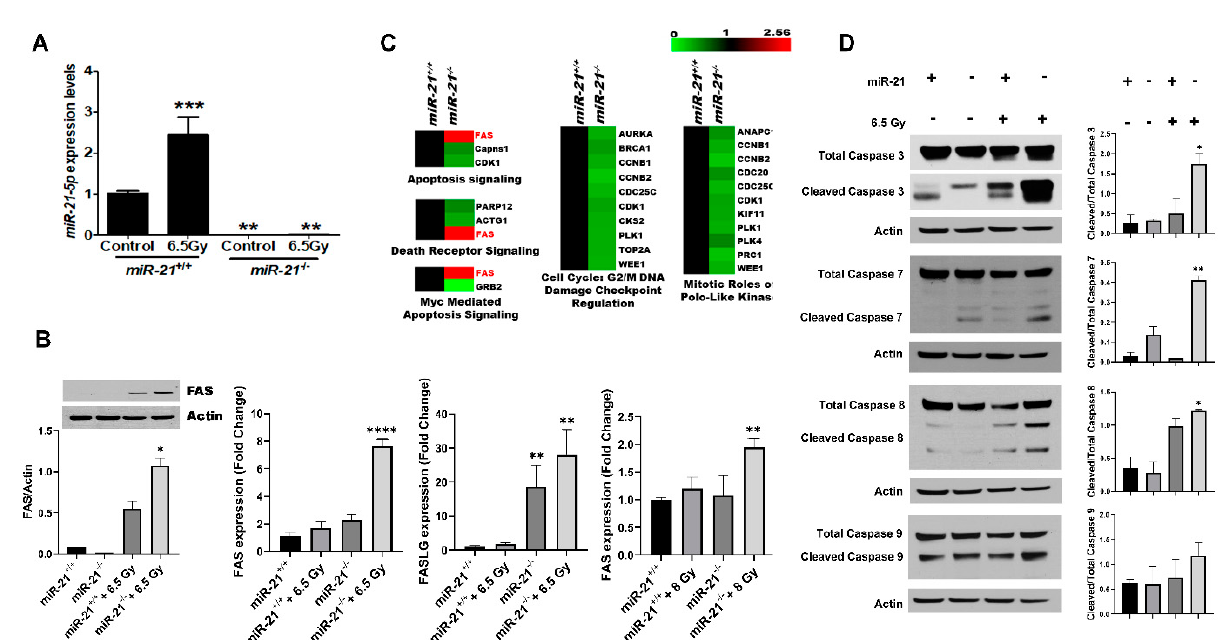
Figure 4. Apoptosis and death receptor signaling pathways contribute to the radiation-sensitive phenotype of the miR-21 − / − mice. ( A ) To investigate the underlying mechanism of radiation sensitivity conferred by loss of miR-21, tumors generated from miR-21 − / − ;MMTV-PyMT and miR-21 +/+ ;MMTV-PyMT mice were exposed to 6.5 Gy irradiation, and collected after 24 h. Irradiation caused a 2.5-fold induction of miR-21 in the tumors derived from miR-21 +/+ ;MMTV-PyMT mice, whereas no increase was noted in the miR-21 − / − tumors determined using one-way ANOVA (***- p < 0.001, **- p < 0.01, n = 3/group). ( B ) As FAS and FASL are known targets of miR-21, the inverse correlation in the expression of miR-21 and FAS was confirmed transcriptionally and at the protein level for Fas in tumors derived from miR-21 − / − ;MMTV-PyMT and miR-21 +/+ ;MMTV-PyMT mice exposed or not to 6.5 Gy. MDA-MB-468 cells were transfected with 60 nM miR-21 inhibitor or scramble with or without 8 Gy. miR-21 inhibition combined with 8 Gy radiation increased FAS expression by 95% ( p < 0.01) compared to control, and 63% ( p < 0.05) compared control tumors treated with 8 Gy. miR-21 inhibition also caused significant increases in the expression of FASLG ( p < 0.01) in tumors, and FAS ( p < 0.01) in MDA-MB-468 cells treated with 8 Gy and miR-21 inhibitor, determined using one-way ANOVA (****- p < 0.000, **- p < 0.01, *- p < 0.05, n = 3/group). ( C ) Ingenuity pathway analysis revealed the activation of apoptosis and death receptor signaling pathways as top canonical pathways. ( D ) Twenty-four hours after radiation, the activation of the caspase 3, 7, 8, and 9 signaling pathways was evaluated in miR-21 − / − and miR-21 +/+ tumors by western blot and quantified. Significant upregulation of cleaved caspases was noted in the miR-21 − / − tumors ( n = 3/group). In detail, caspase 3 was increased by 90%, 7 by 80%, 8 by 70% and 9 by 50% (**- p < 0.01 , *- p < 0.05 . Data represent the difference in means represented as mean ± SEM of three independent mouse tumor tissues normalized to housekeeping genes snoRNA 95, snoRNA96A miRNA, UniSp6, GAPDH mRNA and actin; p < 0.001 or <0.01 as determined by one-way ANOVA with Dunnett’s Post-test.